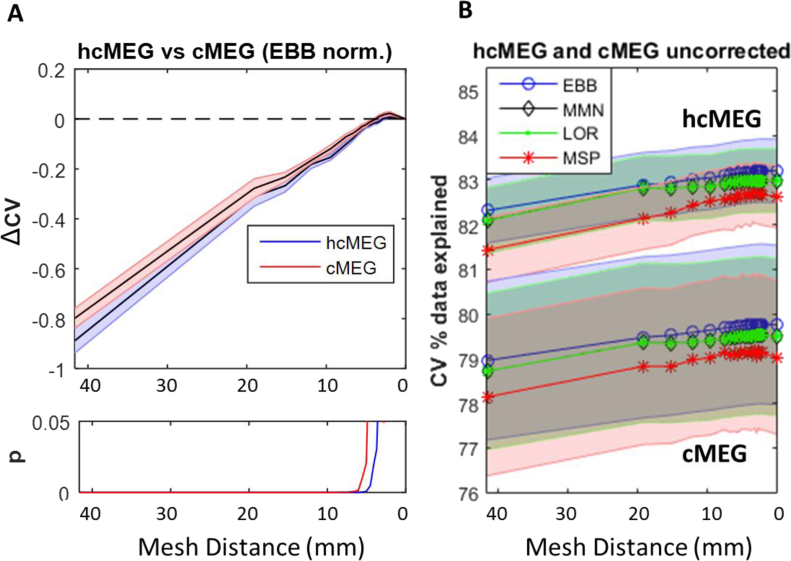
Comparison of head-cast versus conventional MEG cross validation accuracy. A. Comparison of ΔCV for different recording methodologies with head-cast (hcMEG) data showing higher discrimination (3.7 mm) than conventional MEG (cMEG) data (5.0 mm). B. Absolute cross validation data explained is also higher in the head-cast versus the conventional MEG. Note that this holds for all inversion types and for all levels of mesh distortion, but was not significantly different (F = 3.06, p = 0.09).